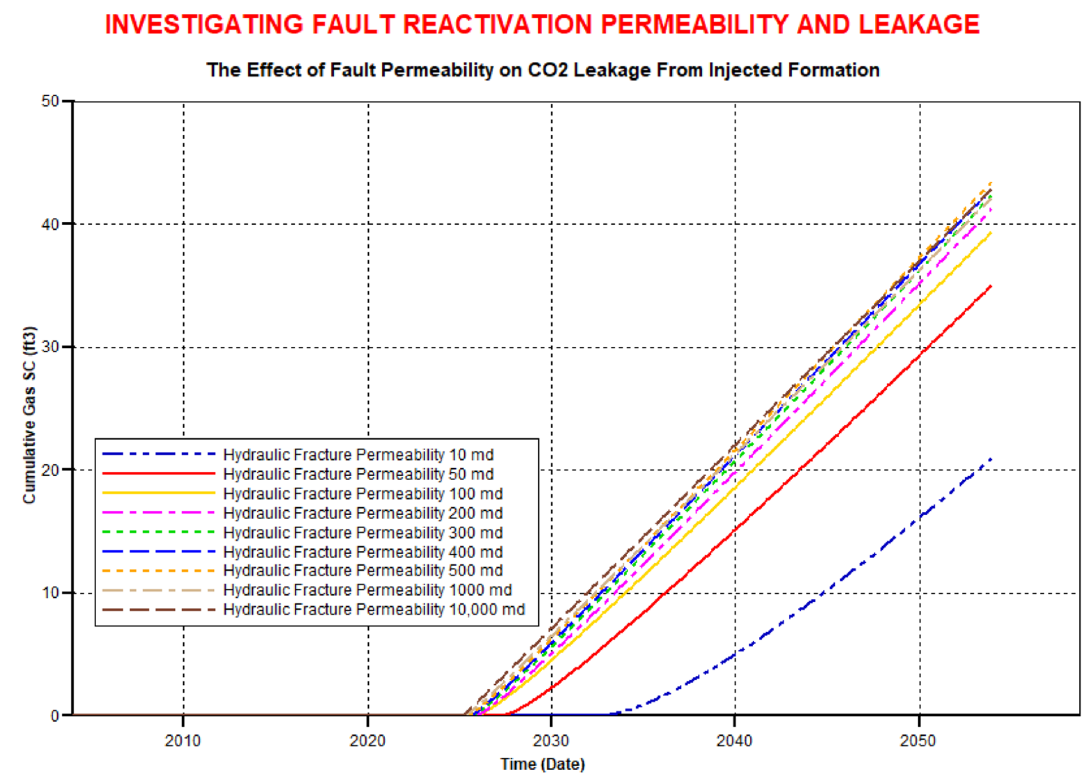
Fig. 21 Leakage volumes of injected carbon dioxide associated with reactivation at the topmost fault block, at varying hydraulic fracture perme- abilities